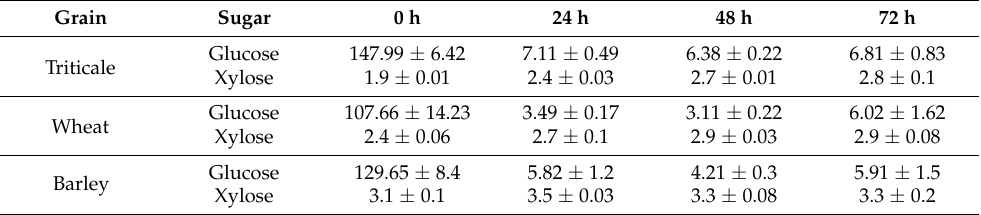
Table 1. Sugar concentrations in starch mashes mg/100